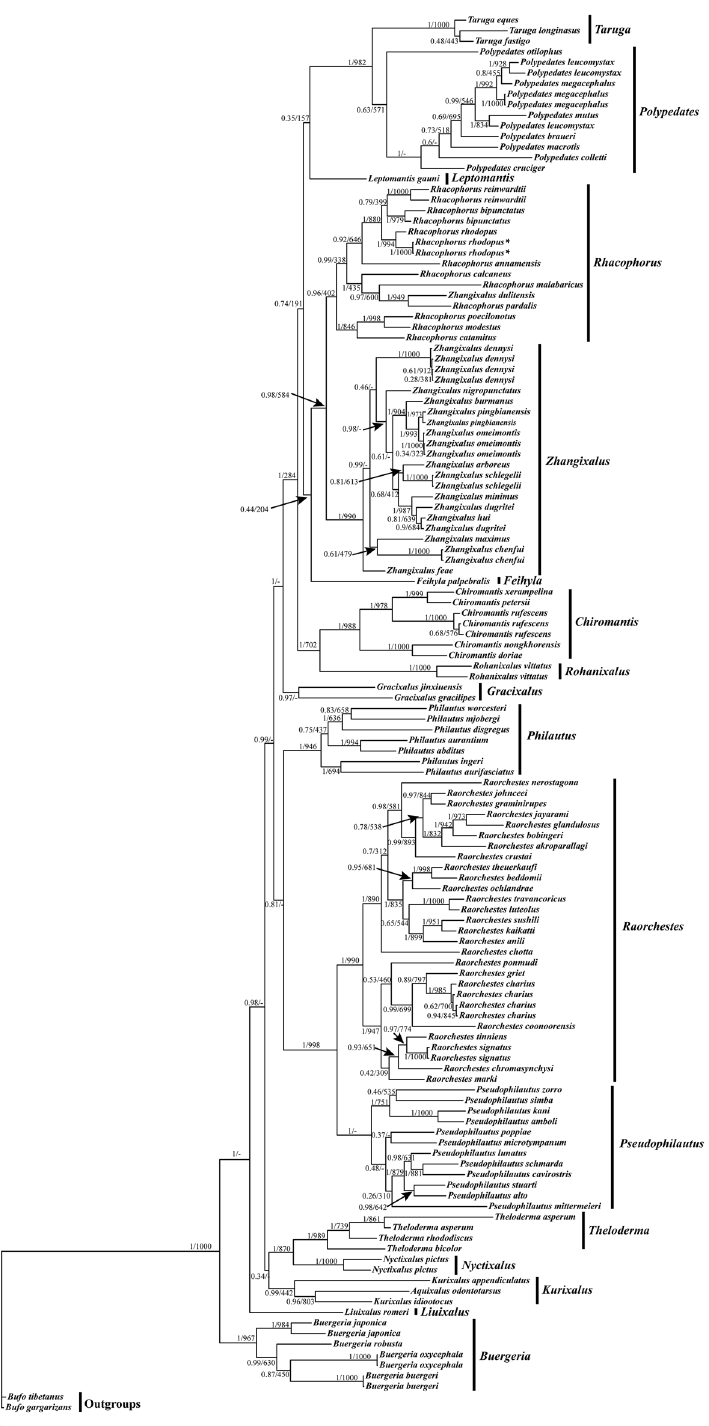
Figure 6. BI and ML analysis of 102 species based on 12S + 16S + CYTB genes sequence. Bufo gargarizans and Bufo tibetanus as outgroups. Tree topologies produced by BI and ML analyses were equivalent. Bayesian posterior probability (PP) and bootstrap support (BP) values for ML analyses are shown in order on the